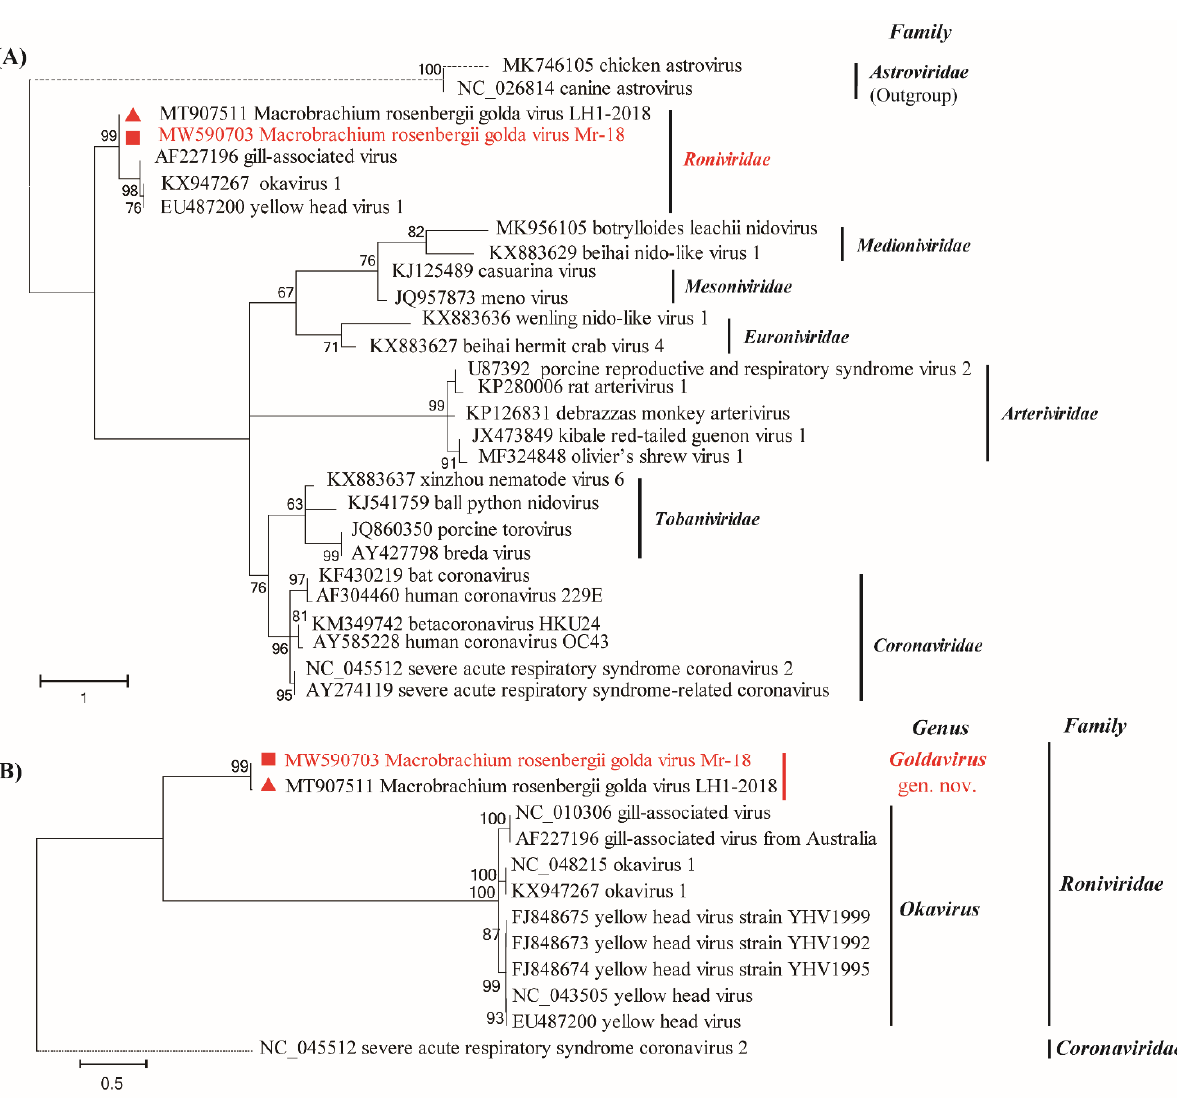
Figure 2. Phylogenetic analysis of the RdRp protein sequences of MrGV Mr-18 and related viruses. ( A ) MrGV Mr-18 and related viruses from the order Nidovirales . ( B ) MrGV Mr-18 and related viruses from the family Roniviridae . All reference sequences were downloaded from GenBank. Multiple sequence alignment of the RdRp protein sequences was performed using ClustalW, and phylogenetic analysis was constructed using the maximum-likelihood method with the LG + G + I/LG evolutionary model in MEGA 7. In total, 1000 bootstrap re-samplings were run. Bootstrap values ≥ 60% are indicated at the nodes. The MrGV Mr-18 is highlighted with a solid red